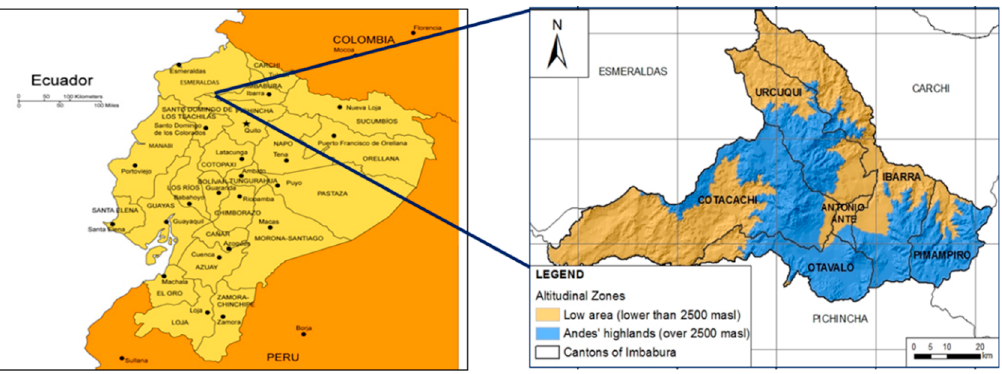
Figure 1. Map of the areas in the Imbabura Province of Ecuador >2500 m above sea level (blue regions) from which the sample of small holder farmers was obtained. (www.freeusandworldmaps.com)